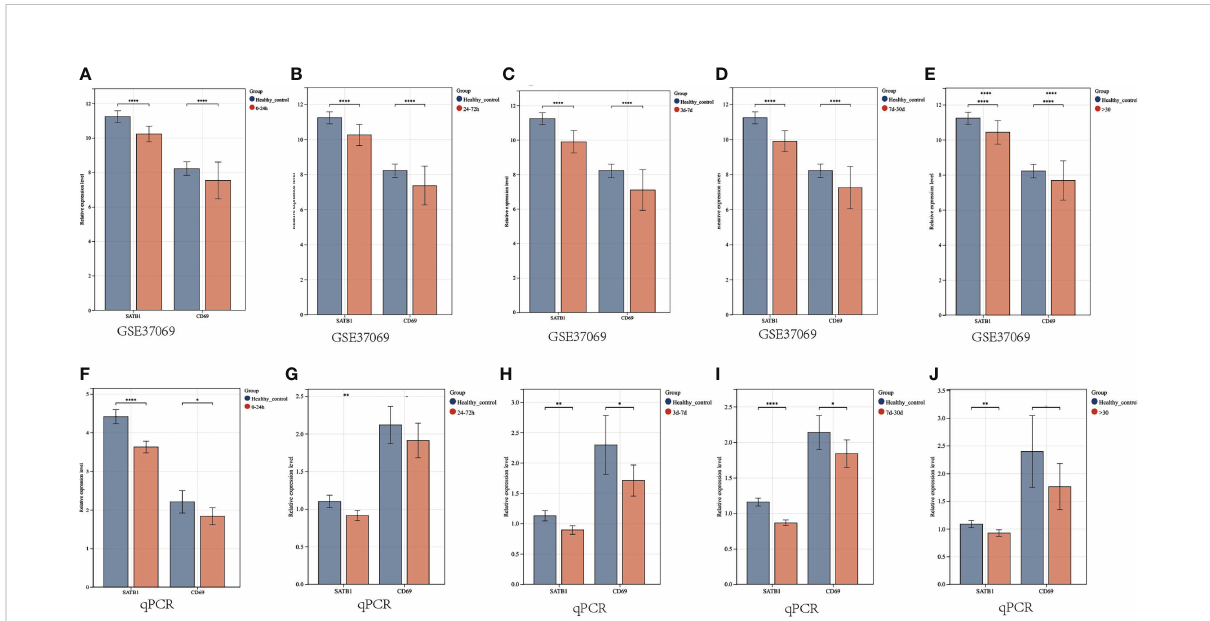
FIGURE 10 Validation of key gene expression. (A – E) Relative expression levels of key genes grouped by microarray at different periods (0-24h, 24-72h, 72h- 7d, 7d-30d, >30d). The ordinate is the relative expression level, and the abscissa is the gene. Red bars are burn patients, and blue are normal controls. (F – J) Relative expression levels of key genes in PCR groups at different periods. P < 0.05:*, P < 0.01:**, P < 0.001:***, P>0.05: